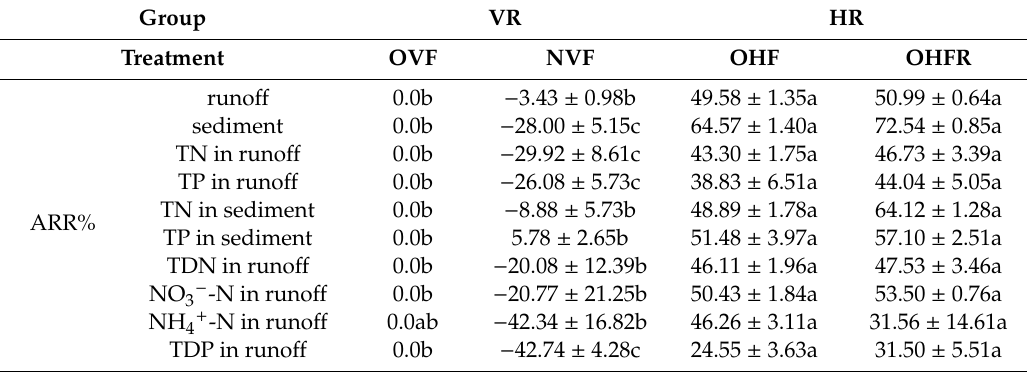
Figure 2. Annual runoff depth ( a ) and sediment loss ( b ) from trial plots during 2014–2017. Error bars represent ± standard errors. Table 2. Average reduction rate (ARR) of runoff, sediment, and nutrients in different treatments during 2014–2017.